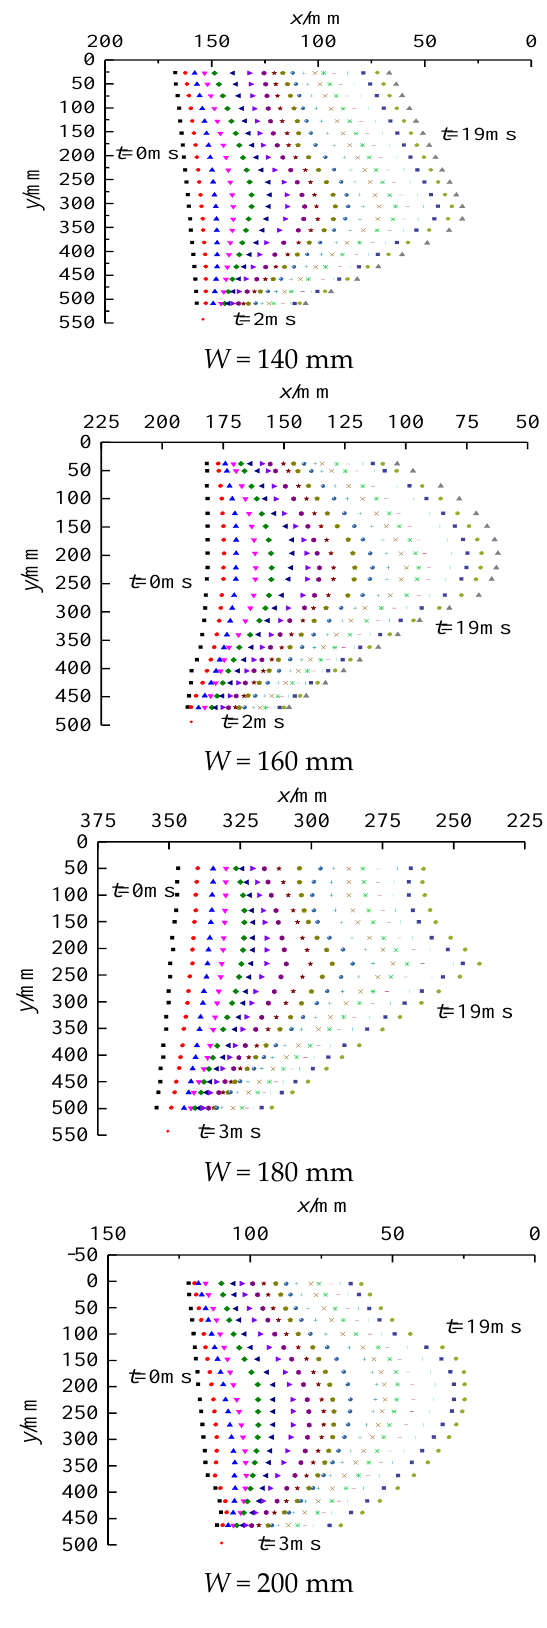
Figure 10. Spatial distribution of particle positions.